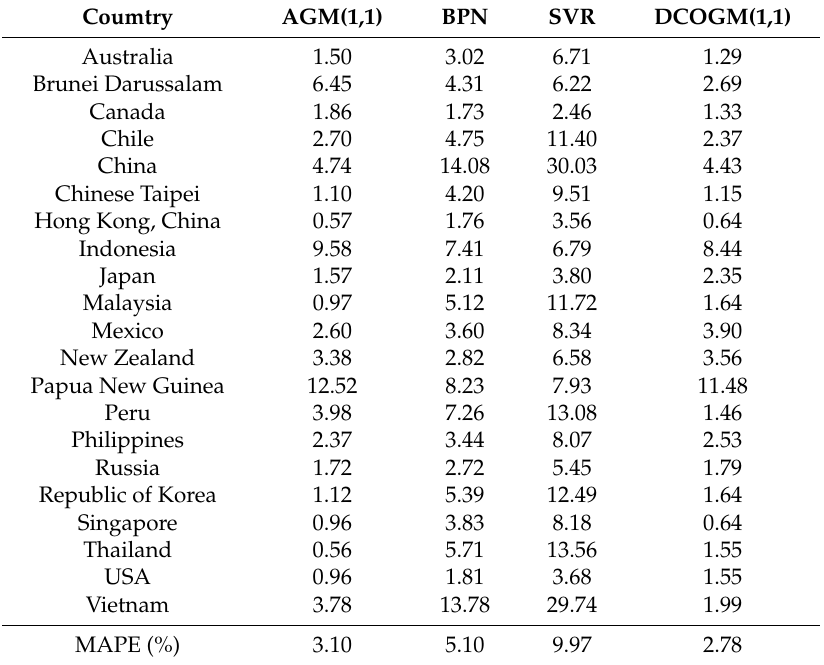
Table 1. Absolute percentage error (APE) and MAPE determined by the four compared models for the electricity consumption in